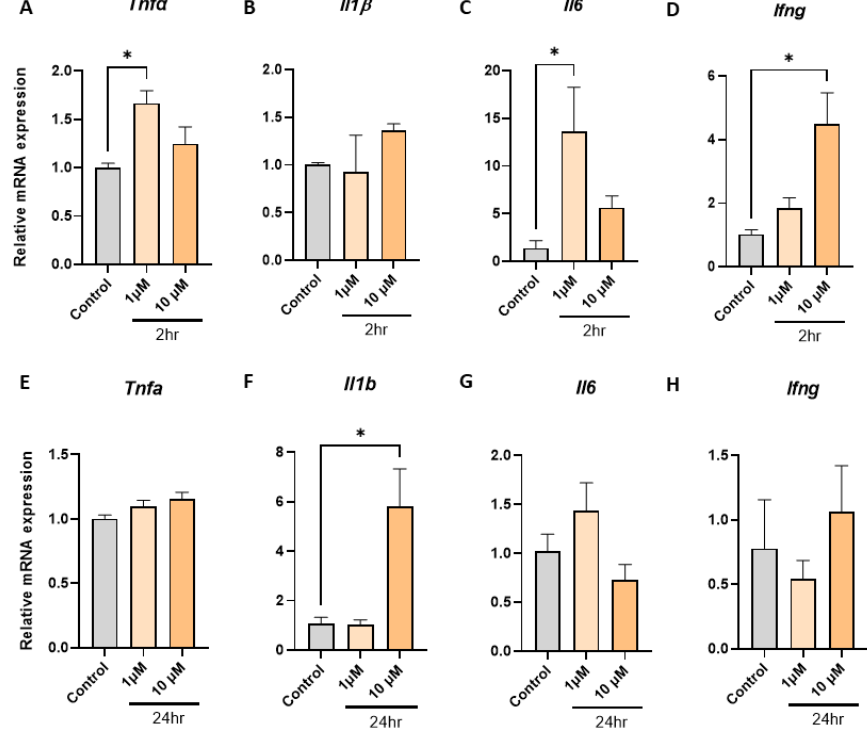
Figure 2. Empagliflozin elicits direct proinflammatory gene expression in BMDM in a time- and dose-dependent manner. ( A – D ) Metformin 2 h, ( E – H ) metformin 24 h ( n = 3 – 4 per group, one-way ANOVA, data are mean ± SEM, * p ≤ 0.05 relative to